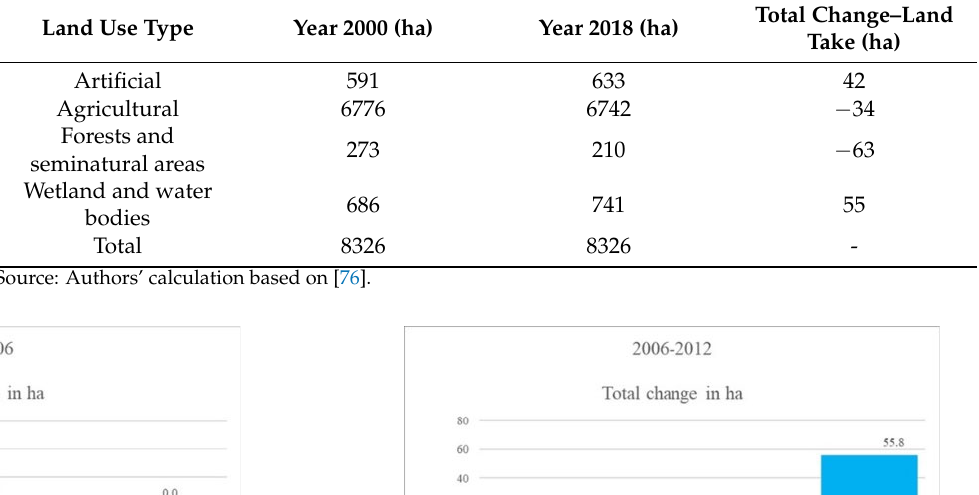
Table 1. Land use dynamics in Futog between